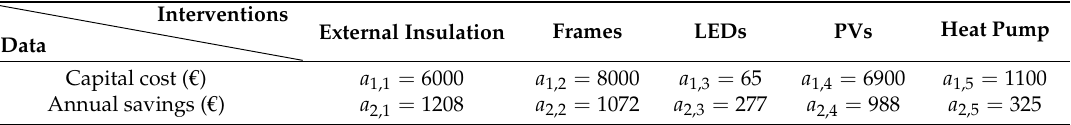
Table 1. Available interventions. LEDs: light-emitting diodes; PVs: photovoltaic